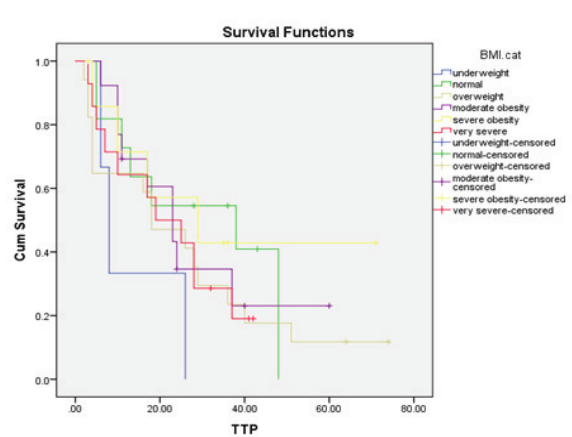
Figure. 4: Kaplan Meier curve showing time to progression of different BMI